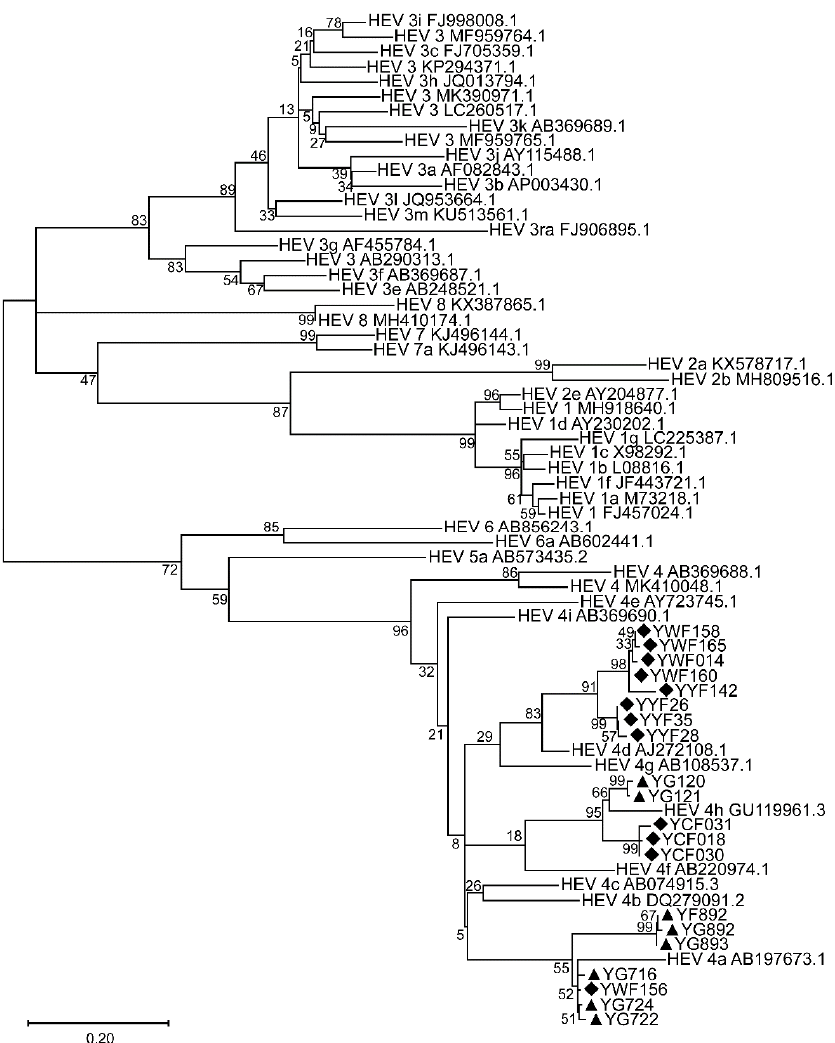
Figure 2. Phylogenetic tree of partial ORF1 of HEV from feral and farmed wild boars. The evolutionary history was inferred by using the Maximum Likelihood method based on the TN93 + G model, a partial nucleotide sequence of the ORF1 region, and reported HEV sequences in GenBank as references. One thousand resamplings of the data were used to calculate percentages (values